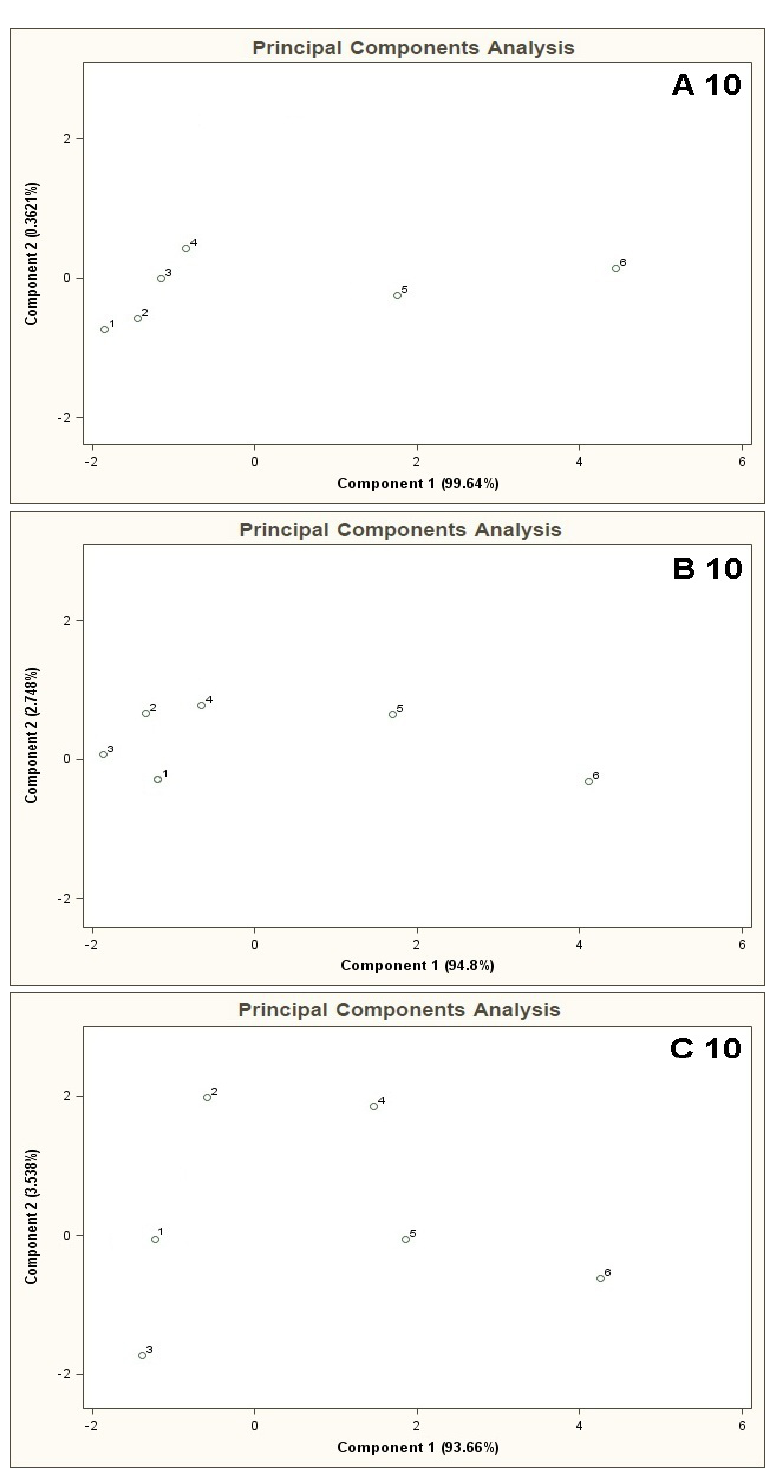
Figure 5. Result of PCA for the mixtures of type A 10 , B 10 , C 10 , where A 10, B 10, C 10 are the aqueous solutions of the basic components (acetone, isoprene, carbon disulphide, propan-2-ol, formamide, benzene, toluene, acetonitrile, acetic acid, dimethyl ether) having the concentration of each component in the mixture equal 10 ppb, 25 ppb and 50 ppb v/v, respectively. 1–6 are the mixtures of reference substances with the COPD markers of the respective concentrations: 0 ppb, 5 ppb, 10 ppb, 25 ppb, 50 ppb, 100 ppb v/v. Measurement was obtained for time instant 60